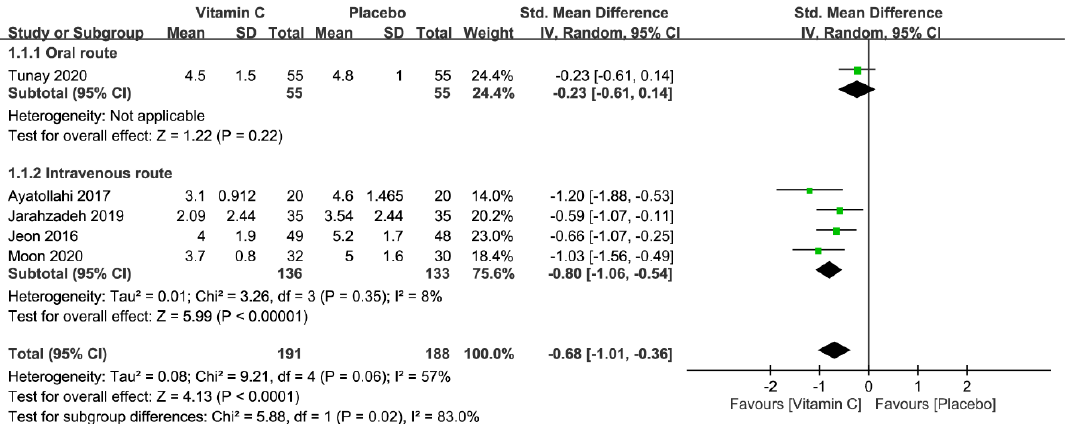
Figure 3. Overall risks of bias of the seven included studies.